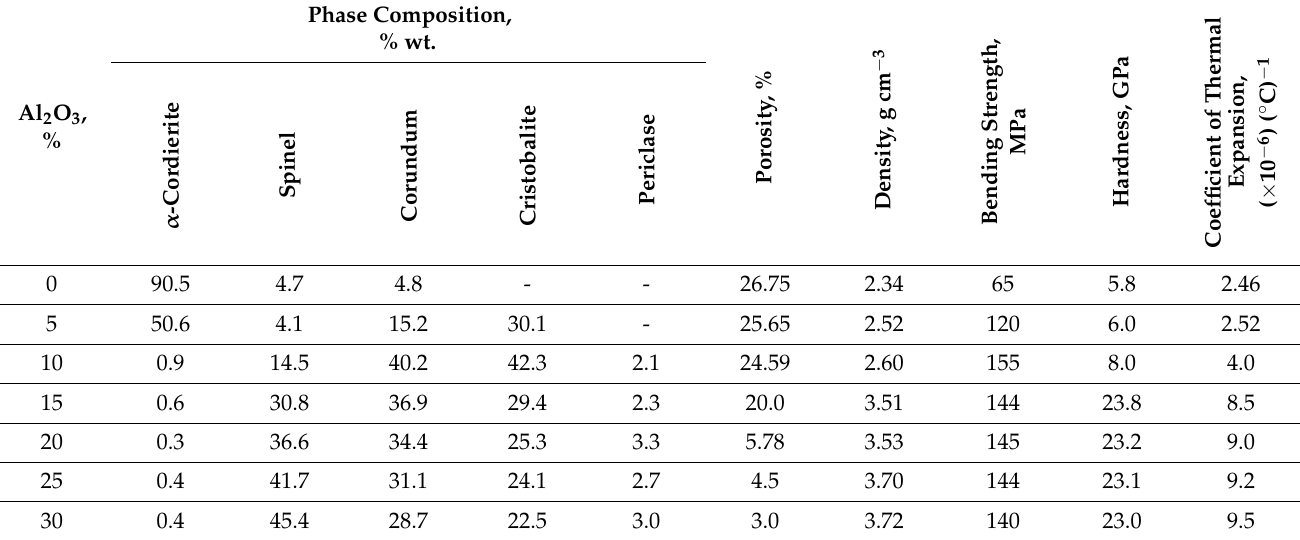
Table 12. Composition and properties of Al 2 O 3 -refractory cordierite from rice husk silica. Data from